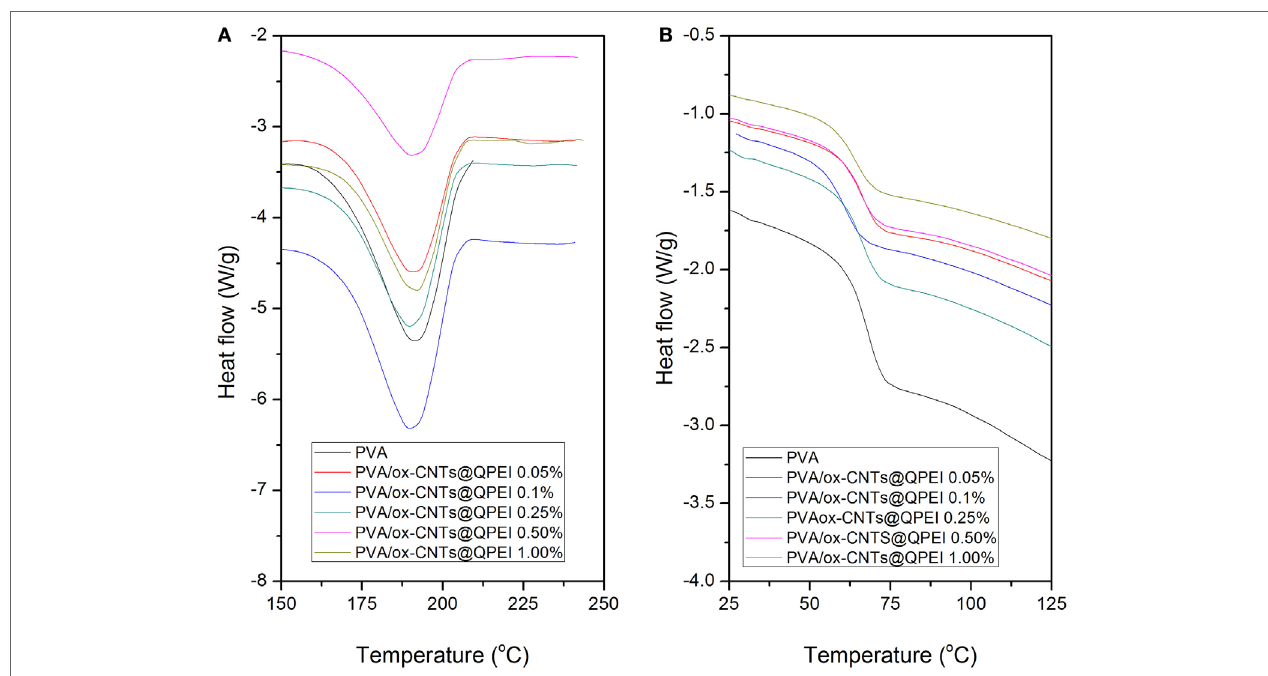
FigUre 8 | Differential scanning calorimetry curves of the pure poly(vinyl alcohol) (PVA) and the PVA/ox­CNTs@QPEI nanocomposite films (a) first heating cycle (melting region) and (b) second heating cycle (glass transition